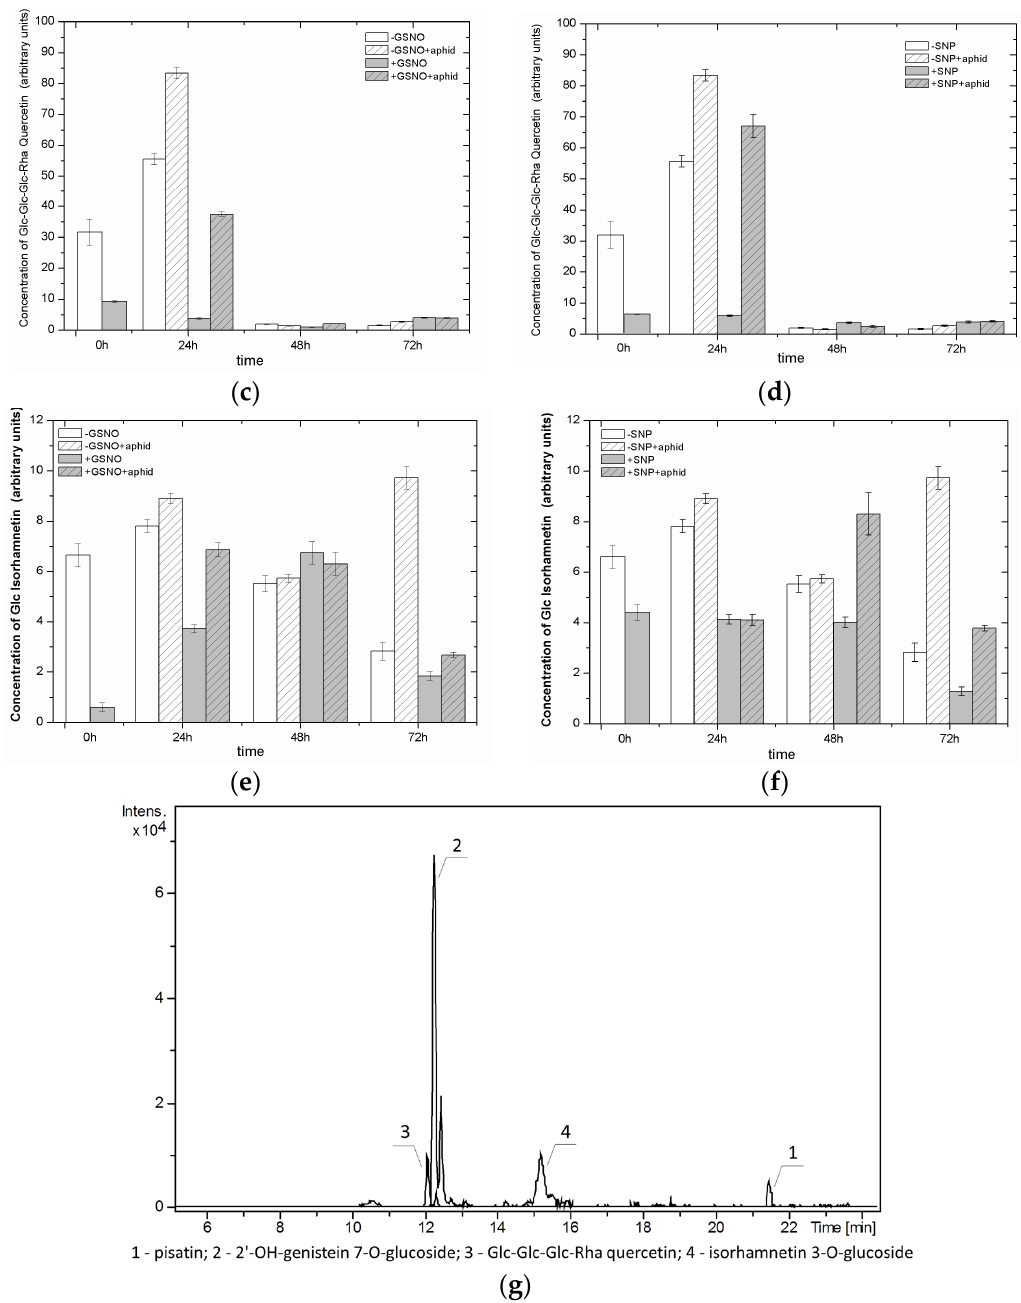
Figure 6. The influence of nitric oxide donors and A. pisum on the level of isoflavonoid and flavonoid glycosides: 2 ′ -OH-genistein 7-O-glucoside ( a , b ); and quercetin rhamnosyl-triglucoside ( c , d ); and isorhamnetin 3-O-glucoside ( e , f ). An LC-MS extracted ion chromatogram showing profiles of phenolic compounds found in pea leaves ( g ). The data were obtained in three independent experiments and statistically analysed using ANOVA ( p -values at α = 0.05). Hypotheses on equality of means were verified by the two-sample t -test (Table S2). To account for multiple testing, we used the Bonferroni correction.